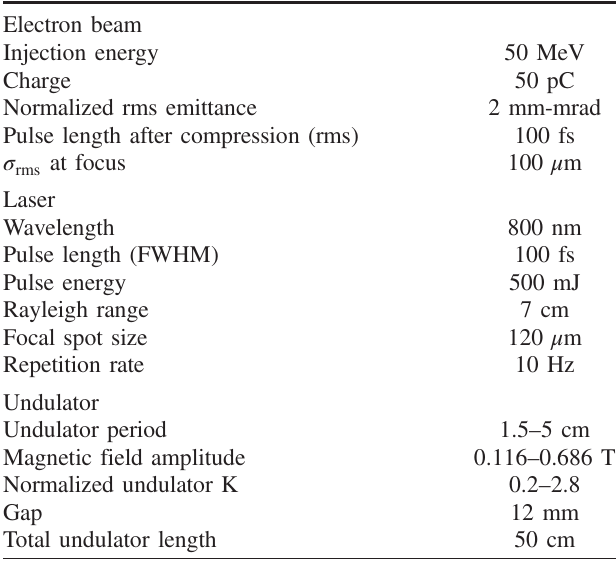
TABLE I. LLNL IFEL design parameters.